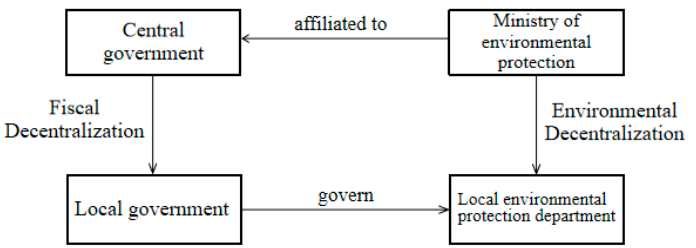
Figure 1. The relationship between fiscal decentralization and environmental decentralization.